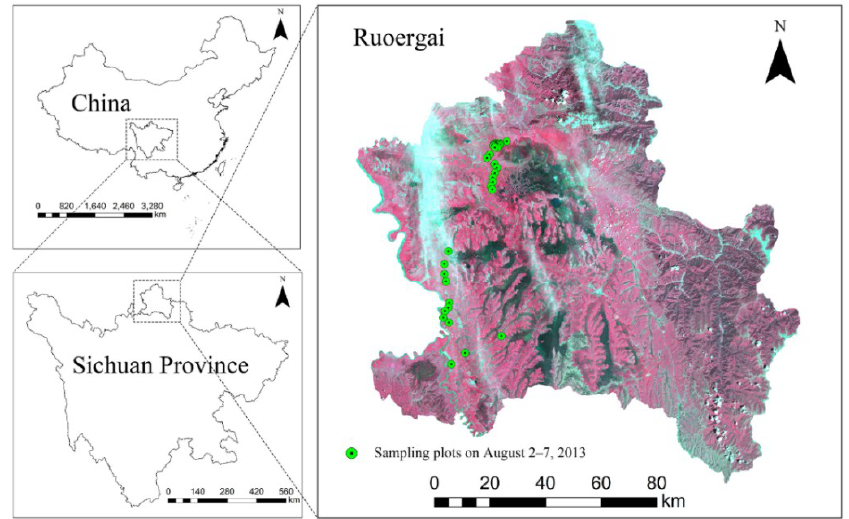
Figure 2. Study area for the validation of CWC and the locations of the sampling plots. The map on the right is a composite image from Landsat